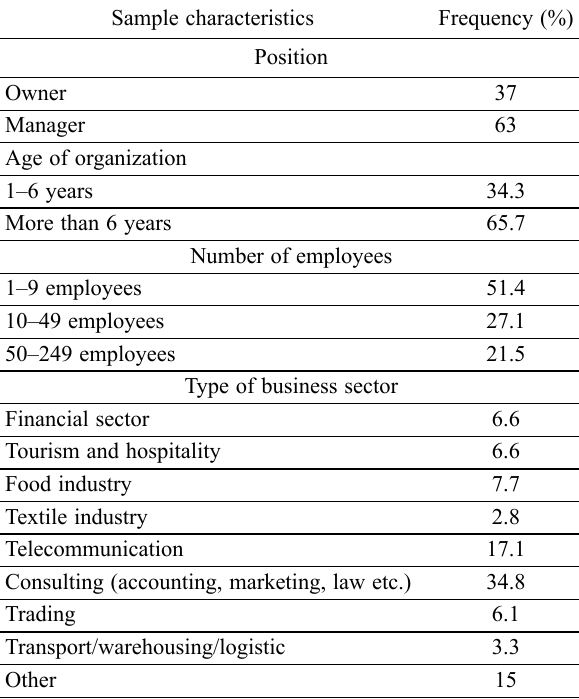
Table 1. Summary statistics of the